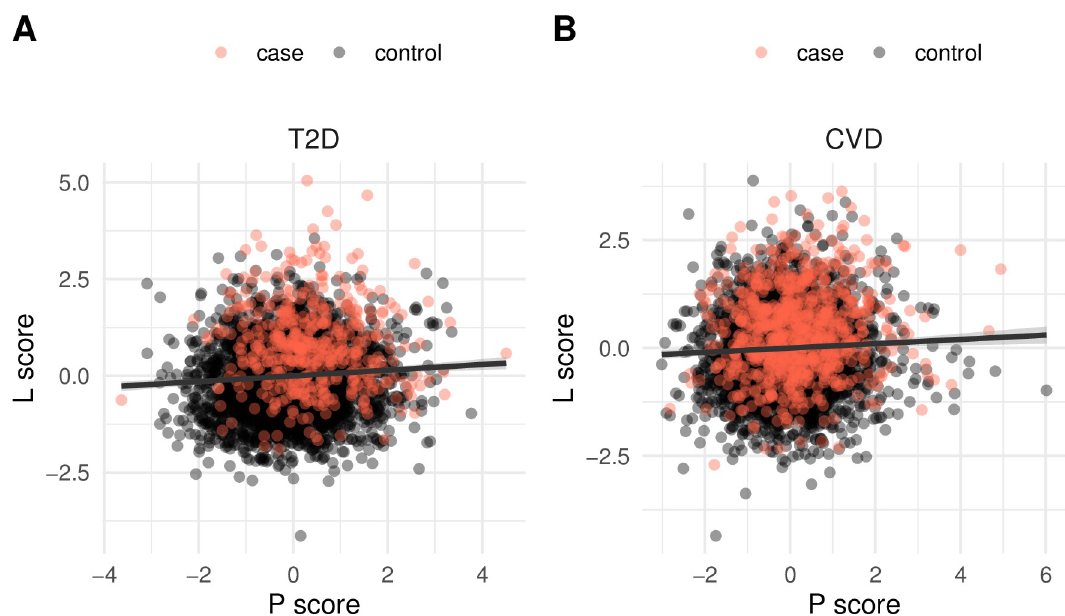
Fig 3. Lipidomic versus polygenic risk. The lipidomic risk (L score) is compared to the polygenic risk (P score) for T2D (A) and CVD (B). Pearson’s r = 0.087 and 0.045 for T2D and CVD, respectively. The risk scores are average values from 10 independent replications. The curve shows a least squares fit of a linear model to the data. The data underlying this figure may be found in S1 Data. CVD, cardiovascular disease; T2D, type 2 diabetes.